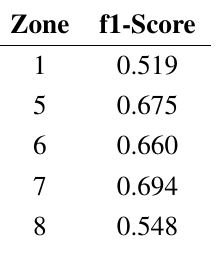
Table 3. f1-score of classification using gaussprRadial and 5 zones in Building